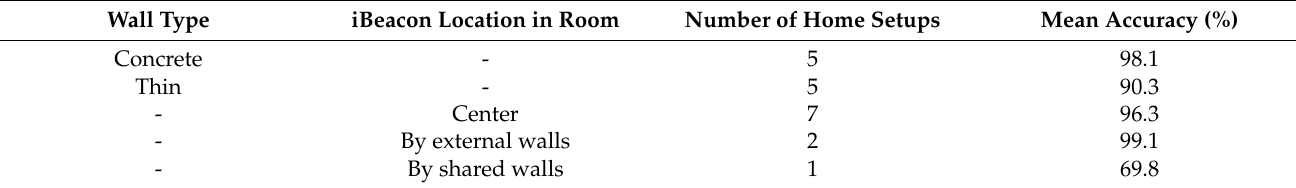
Table 2. Impact of wall type and sensor placement on accuracy during our internal study. Note that the number of home setups is some cases (e.g., iBeacon placement by external/shared walls) is very low and is only an indication of possible